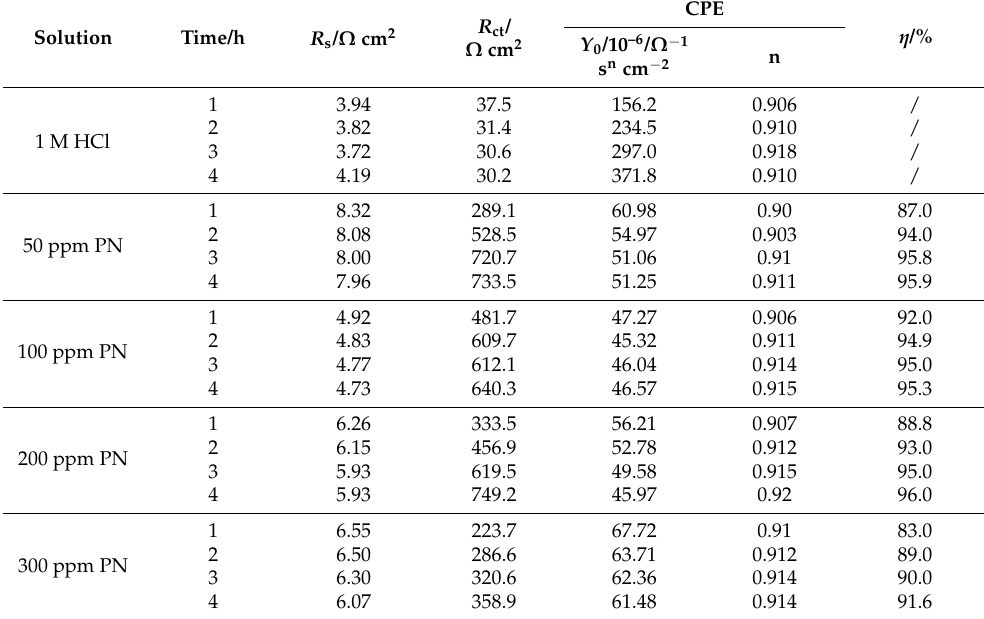
where Y 0 is the CPE magnitude, n is the deviation parameter, j represents the imaginary root, ω is the angular frequency, and f is the frequency at the maximum value of the im ‐ aginary part of the spectrum on the diagram. Table 2. Impedance parameters for carbon steel after 1-4 h immersion in 1 M HCl in the presence and absence of